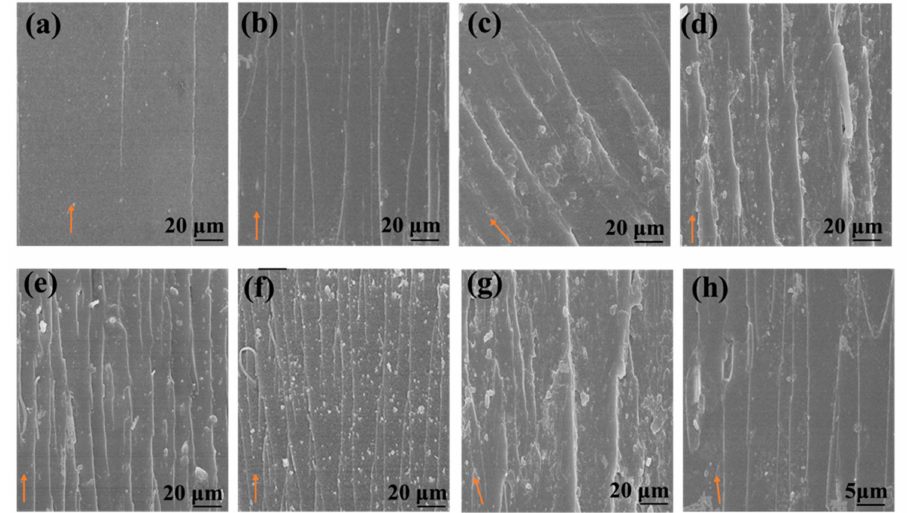
Figure 7. SEM images of epoxy composites with graphene fillers in wt. % ( a ) Neat epoxy ( b ) GO 0.04 ( c ) GO0.08 ( d ) GO 0.2 ( e ) HMTA-GO 0.04 ( f ) HMTA-GO 0.08 ( g ) HMTA-GO 0.2. h is the higher magnification image of HMTA-GO 0.2 (arrows indicate direction of crack